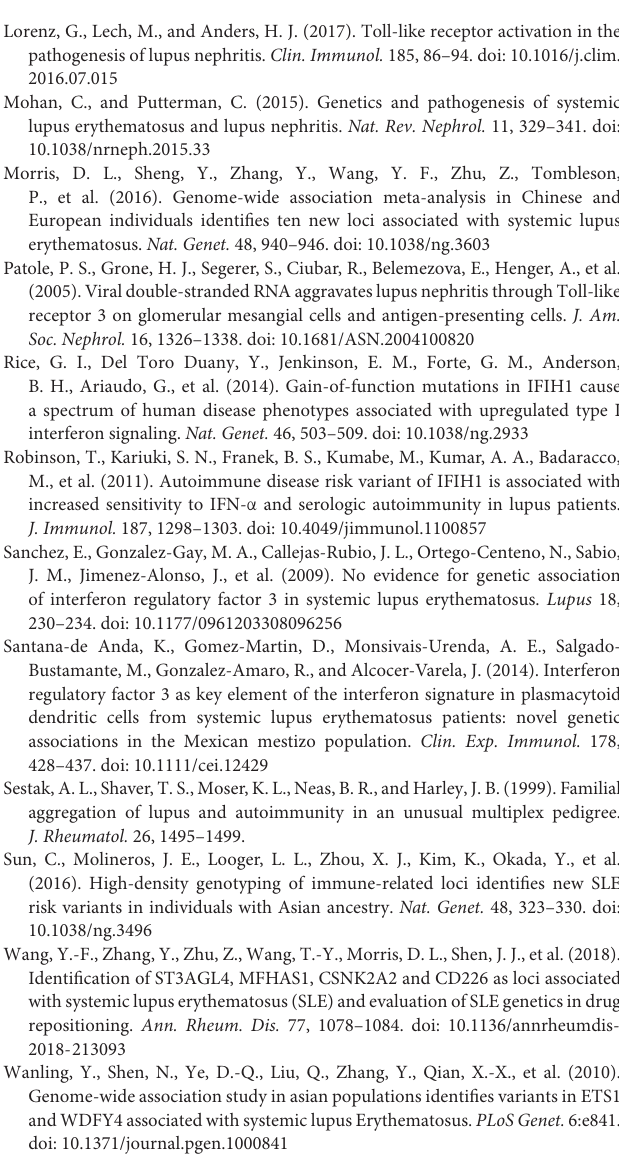
FIGURE S1 | IRF3 alignment on different species. FIGURE S2 | The expression of IRF3 in immune